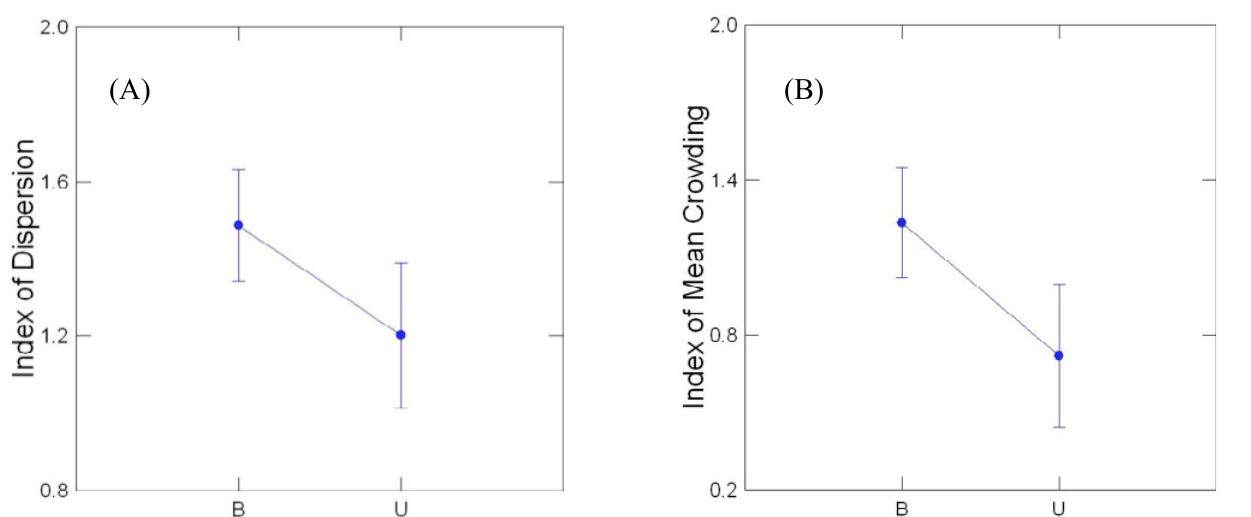
Figure 2. Aggregation metrics of Red Hills salamander burrows in Alabama, USA. ( A ) Average index of dispersion (ID) and ( B ) average index of mean crowding (IMC), with vertical bars extending to the minimum and maximum values, for buffered (B) and unbuffered sites